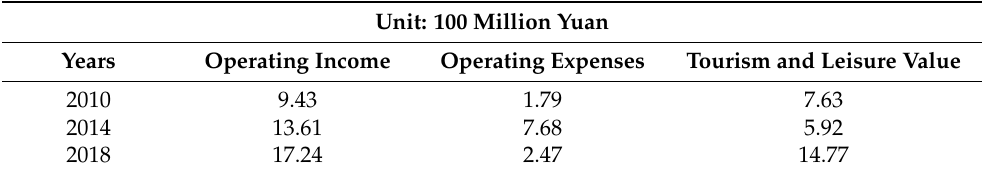
Table 12. Tourism and leisure value of Taihu Lake national tourist attractions.